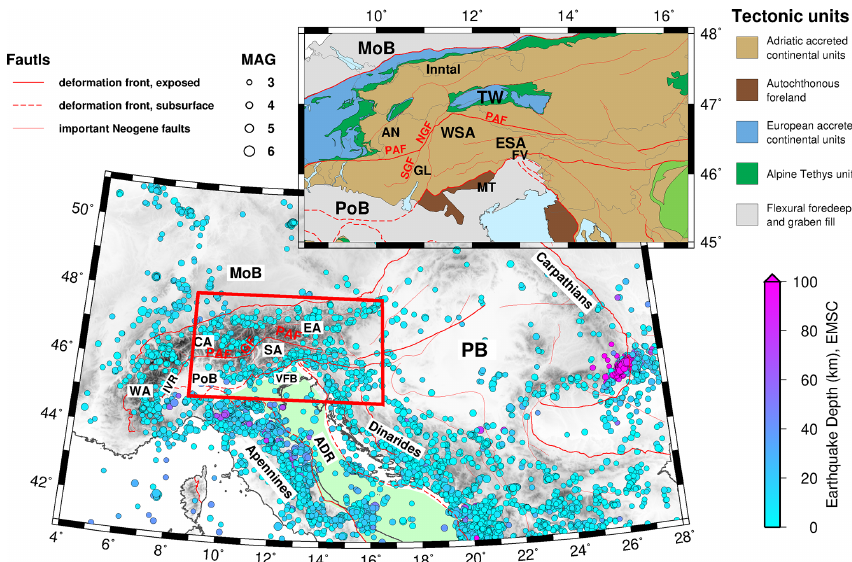
Figure 1. Geological map of the Alps showing major deformation fronts, faults, geographical subdivisions, tectonic units, and seismicity (seismic events between January 2000 and December 2012 with a magnitude larger than 3 from the European-Mediterranean Seismological Centre). The light green zone indicates the outline of the Adriatic plate. The tectonic units of the study area (red box) are shown on the upper-right inset map. The maps are modified from Handy et al. (2010) and Schmid et al. (2004, 2008). Abbreviations are as follows: WA stands for western Alps, CA stands for central Alps, SA stands for southern Alps, EA stands for eastern Alps, ADR stands for Adriatic plate, IVR stands for Ivrea body, PB stands for Pannonian Basin, VFB stands for Venetian-Friuli Basin, PoB stands for Po Basin, MoB stands for Molasse Basin, TW stands for Tauern Window, PAF stands for Periadriatic Fault, NGF stands for northern Giudicarie Fault, SGF stands for southern Giudicarie Fault, ESA stands for eastern southern Alps, WSA stands for western southern Alps, MT stands for Montello, GL stands for Giudicarie–Lessini region, FV stands for Friuli-Venetia region, and AN stands for Austroalpine nappes.